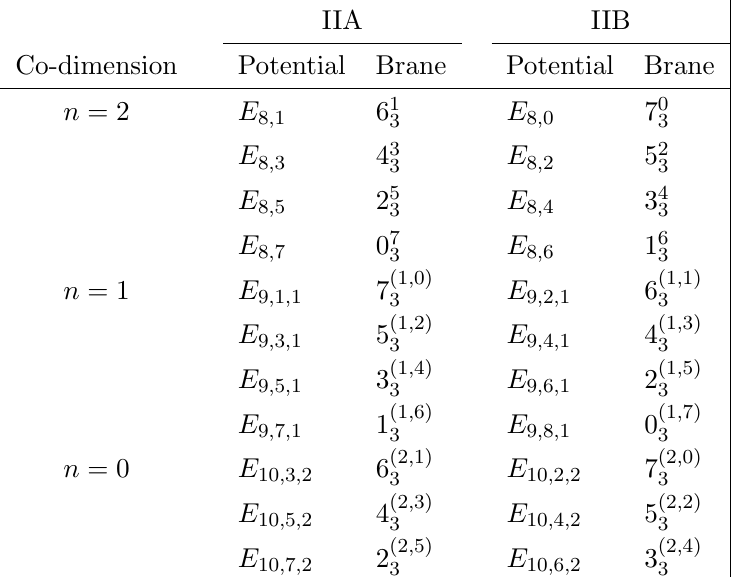
Table 2 . The mixed-symmetry gauge potentials that the exotic branes couple to, sorted by co- dimension n , for both Type IIA and Type IIB